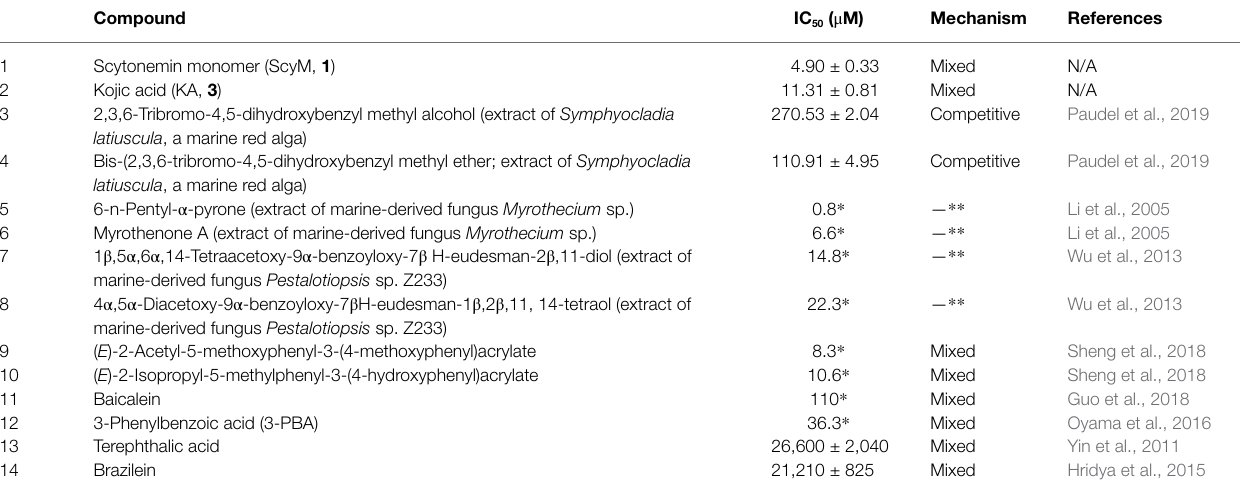
TABLE 3 | Mushroom tyrosinase inhibitory activity of selected compounds from previous publications, in comparison with the positive control used in this experiment (KA) and the newly discovered inhibitor scytonemin monomer (ScyM). Compound